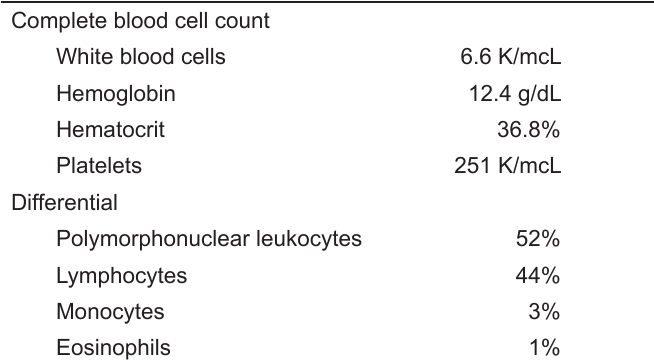
Table 1. Complete blood cell count of 18-year-old patient presenting with mental status changes, fever, and a family history of autoimmune